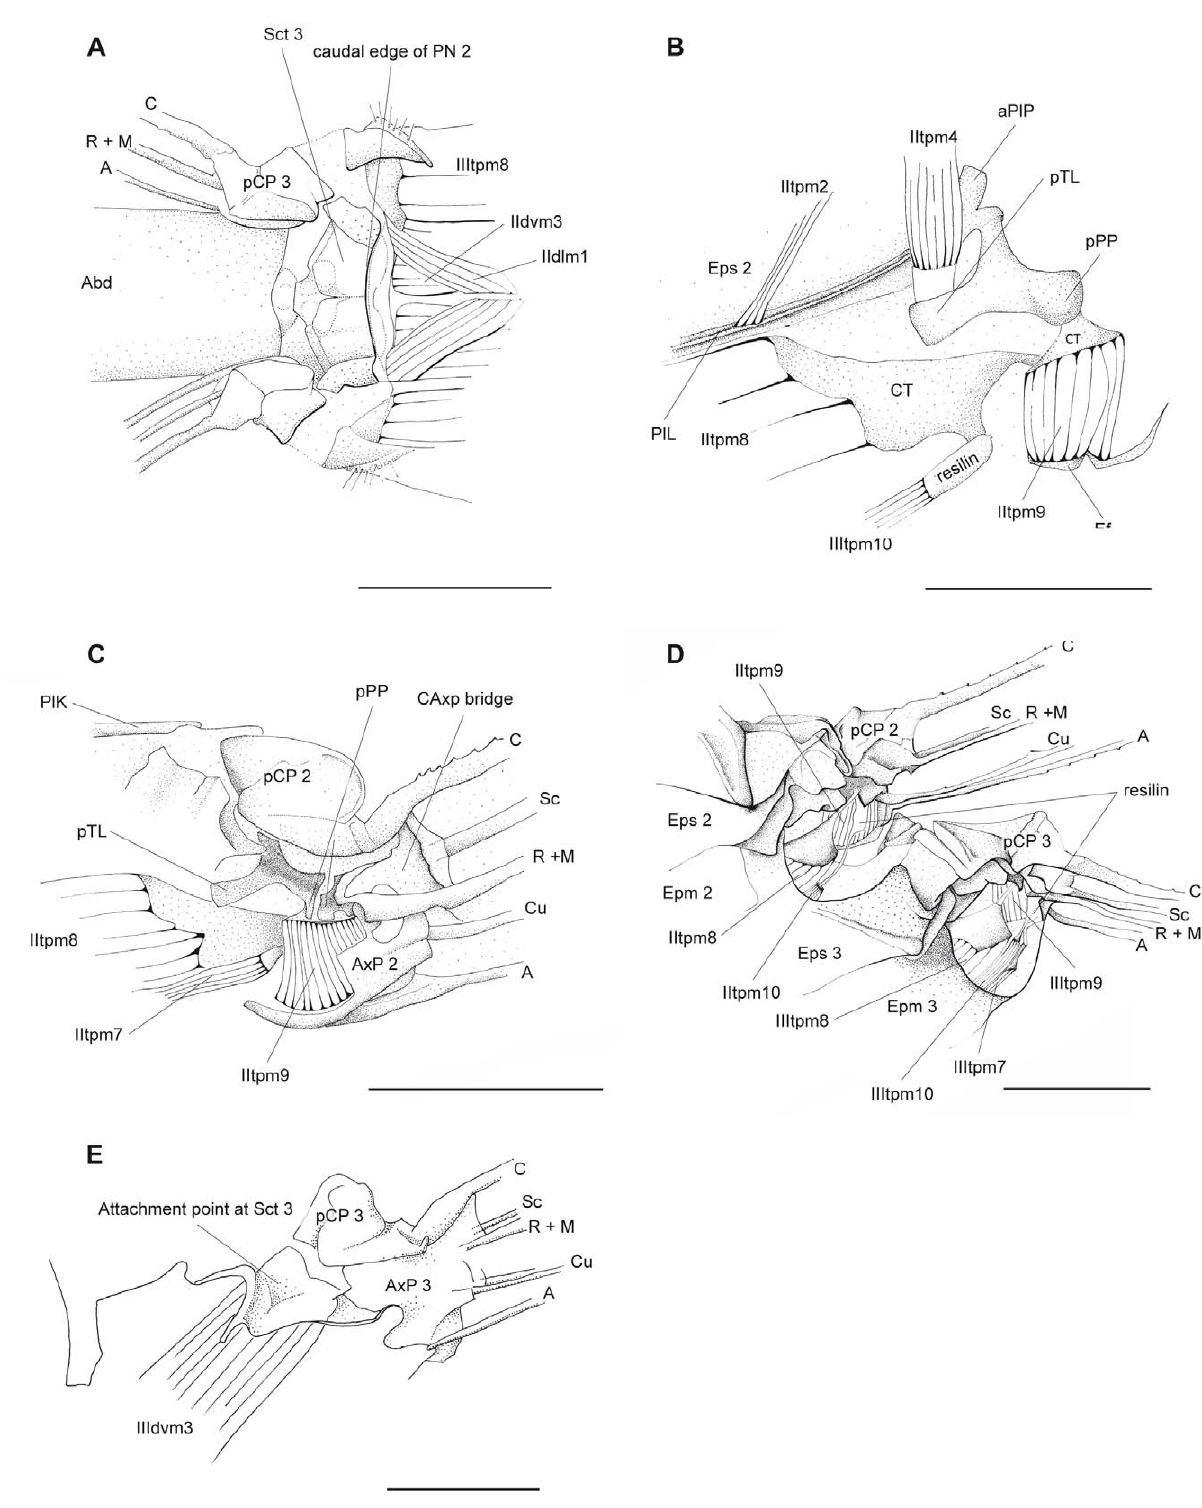
Figure 6. P.nymphula , thorax details. A Points of origin of muscles IIdlm1, IIIdvm3 and IIItpm9. Dorsal view. B Detail of lateral flight muscles, longitudinal section, right. C Attachment points of muscles IItpm9, IItpm6 and IItpm8. Longitudinal section, right. D Detail of wing articulation area of the meso- and metathorax, left lateral view. E Attachment of muscle III dvm3. Longitudinal section, right. Abbreviations: A – anal vein, aPlP - anterior pleural process, AxP – axillary plate, C – costa, CAxP bridge - costa-axillary plate bridge, CT – cap tendon, Cu – cubitus, Epm – epimeron, Eps – episternum, M – media, pCP - proximale costal plate, PIL - pleuralbar, PlK – pleuralkeel, PN – postnotum, pPP – posterior pleural process, pTL - posterior tergal levler, R – radius, Sc – subcosta, Sct – scutum.